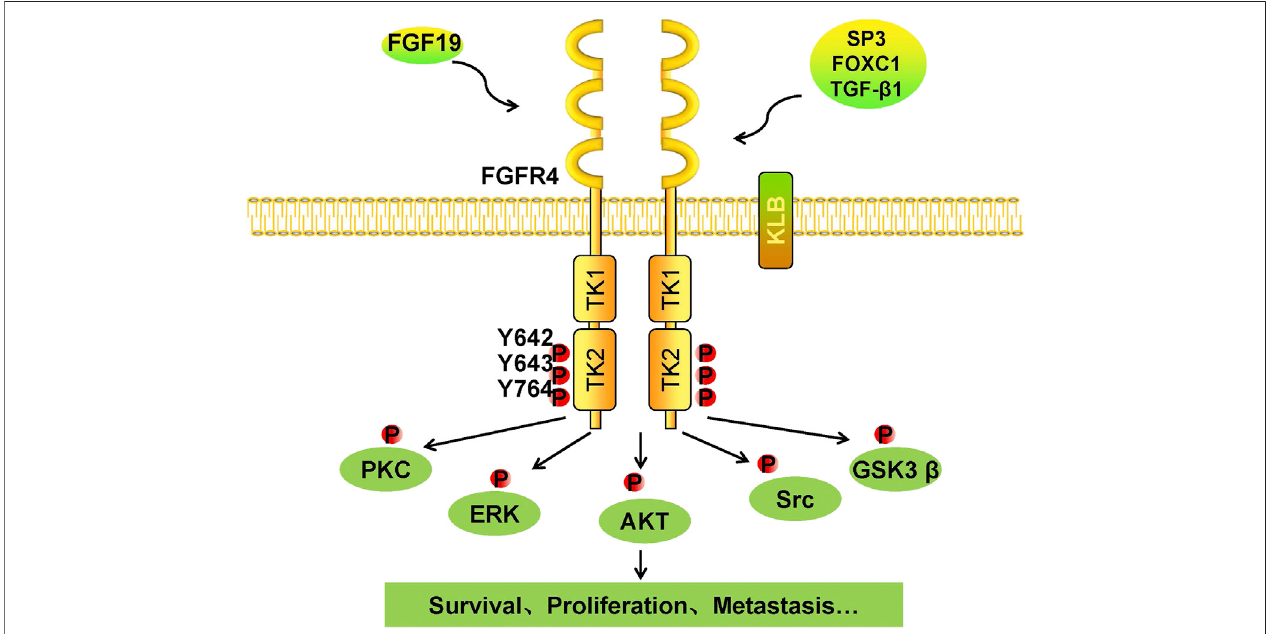
FIGURE 3 | Tumorigenic mechanism of the FGF19/klotho/FGFR4 signaling pathways. Once FGF19 binds to FGFR4 with klotho, tyrosine residues in the intramembrane TK2 domain are phosphorylated, and FGFR4 is activated. Phosphorylated FGFR4 activates downstream kinases, including PKC, ERK, AKT, Src, and GSK3 β . Cells respond to these activated kinases, and survival, proliferation, and metastasis result.